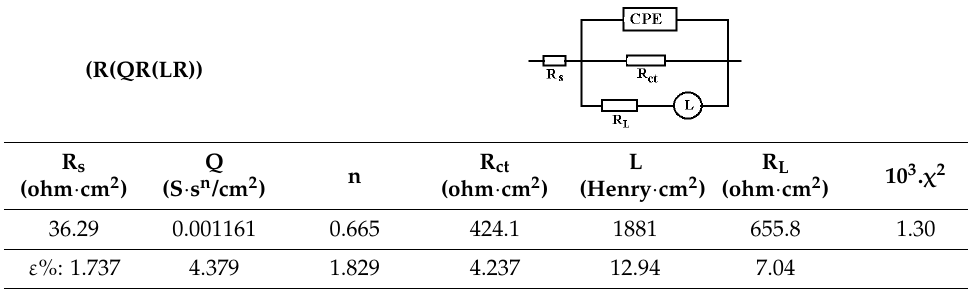
Table 6. The values of the equivalent circuit for sample C.